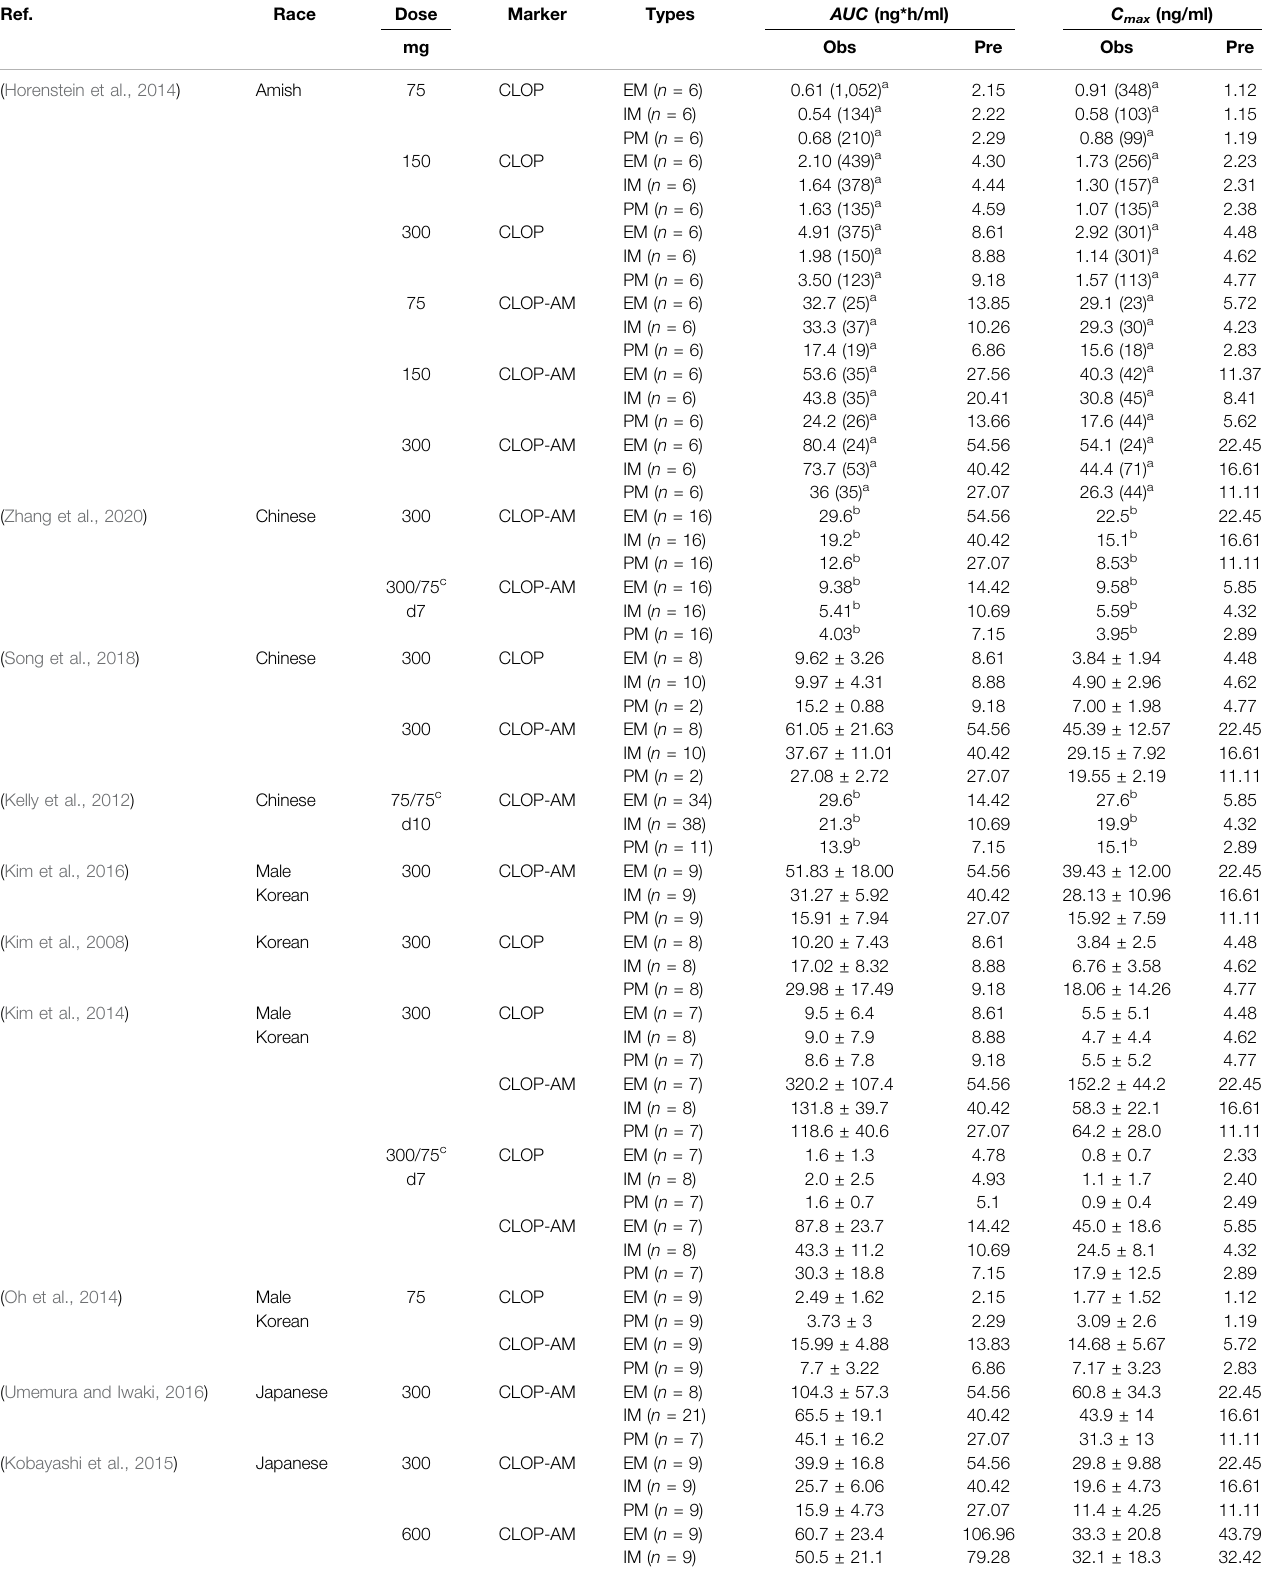
TABLE 4 | The observed and predicted plasma pharmacokinetics parameters in healthy subjects. Ref.